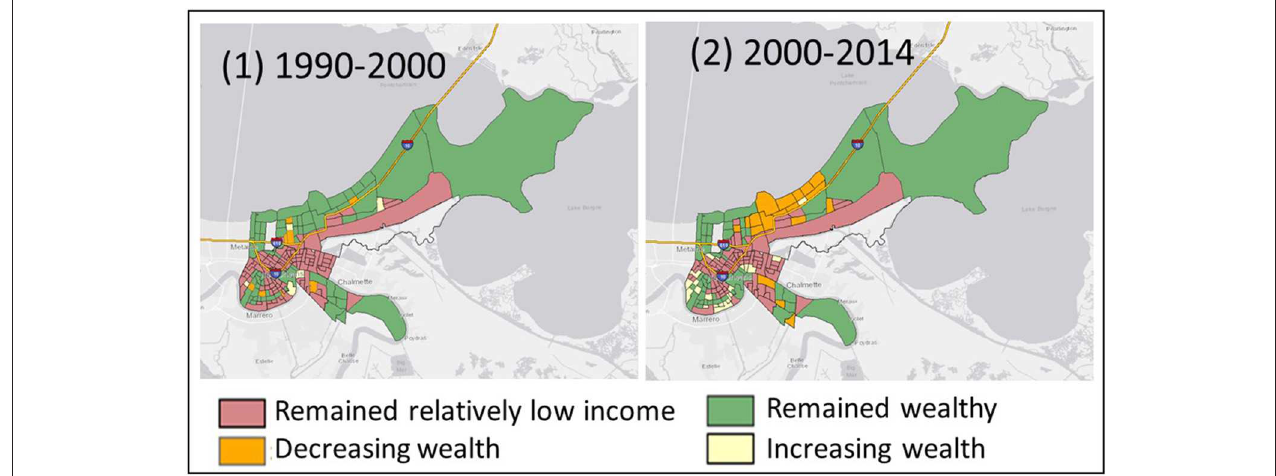
FIGURE 3 | Spatial distribution of income change between (1) 1990 and 2000; and (2) 2000 and 2010.